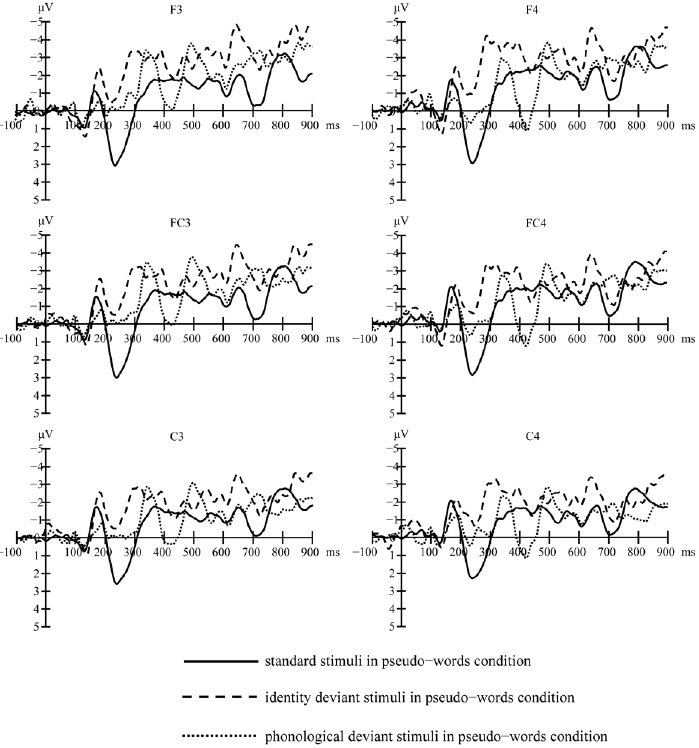
Figure 2. Grand-average waveforms evoked by the standard and deviant stimuli in pseudo-words’ condition at electrode locations F3, F4, FC3, FC4, C3, and C4.